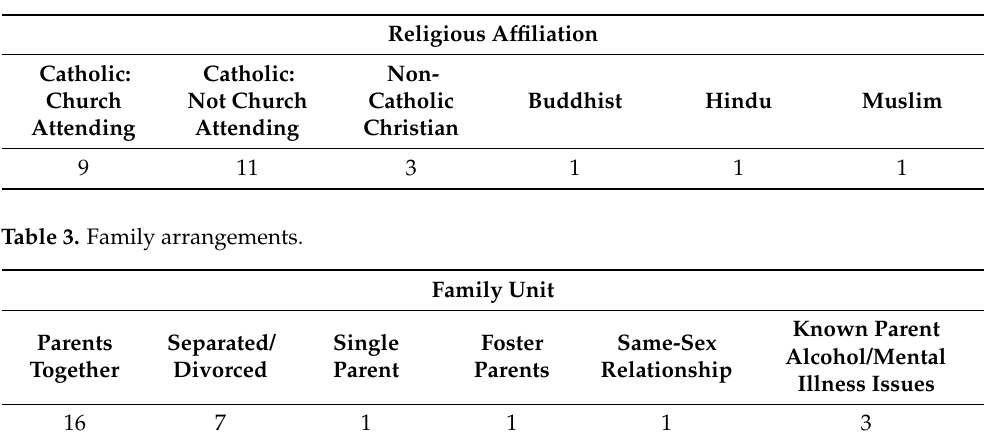
Table 2. Religious affiliation.